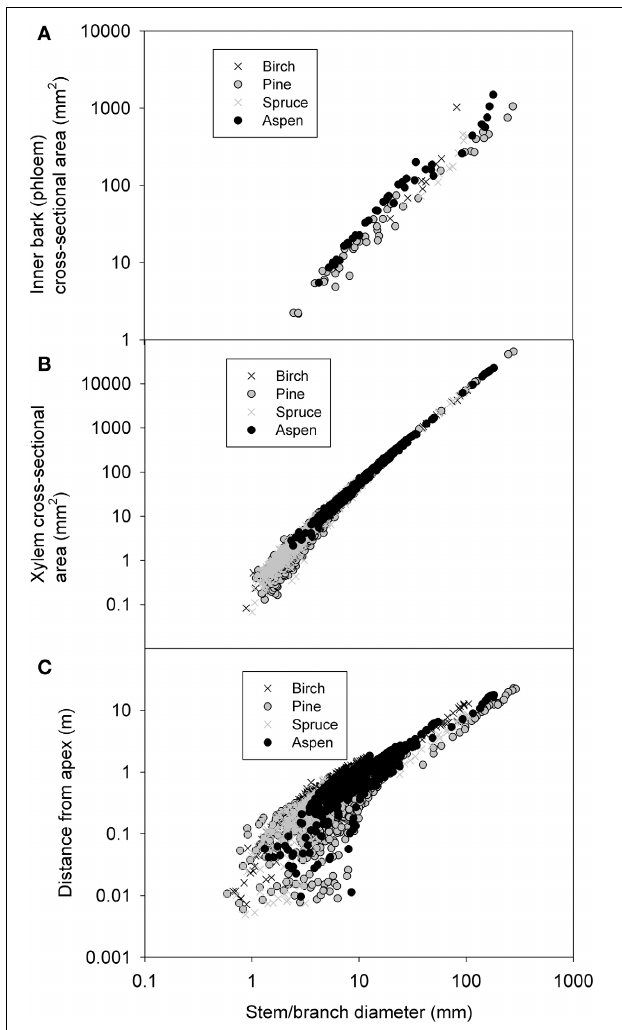
FIGURE 2 | Measured inner bark (i.e., phloem) cross-sectional area (A), xylem cross-sectional area (B), and distance from leaf apex (C) as a function of stem/branch